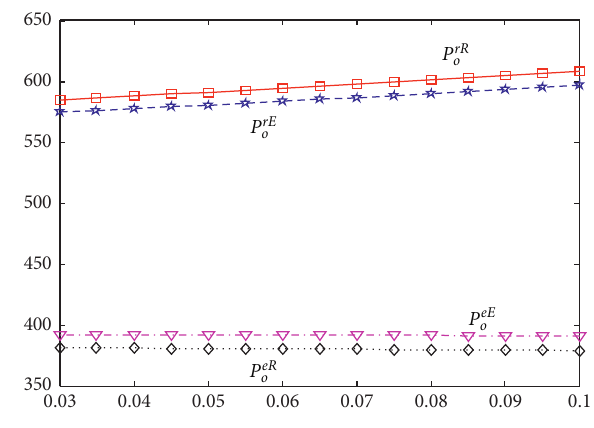
Figure 4: Optimal EW price over ρ .